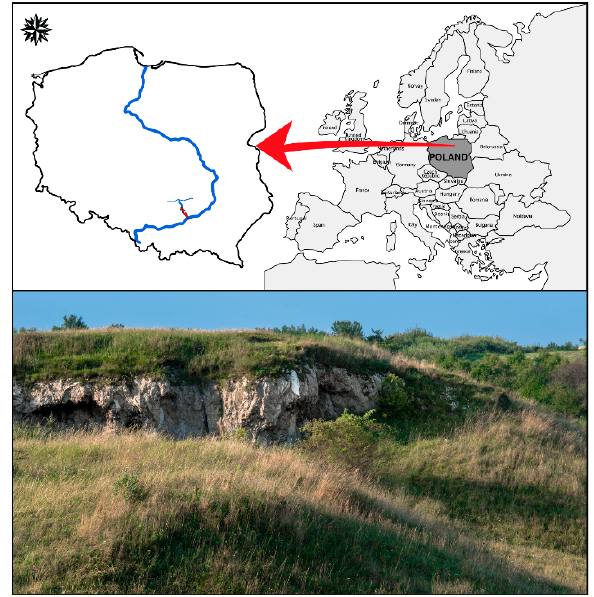
Figure 1. Collection sites in the Nida Basin on map of Poland showing the geographic location of the studied xerothermic grasslands (marked in red).